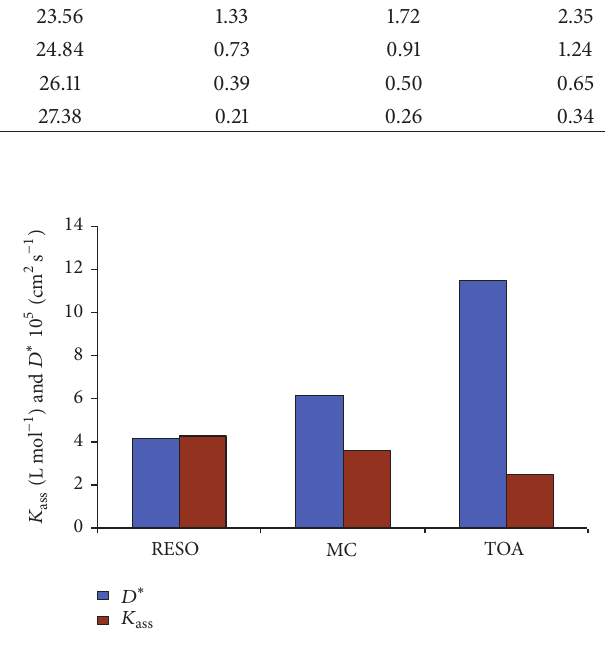
Figure 9: Microscopic parameters evolution for facilitated extrac- tion phenomenon of VO 2+